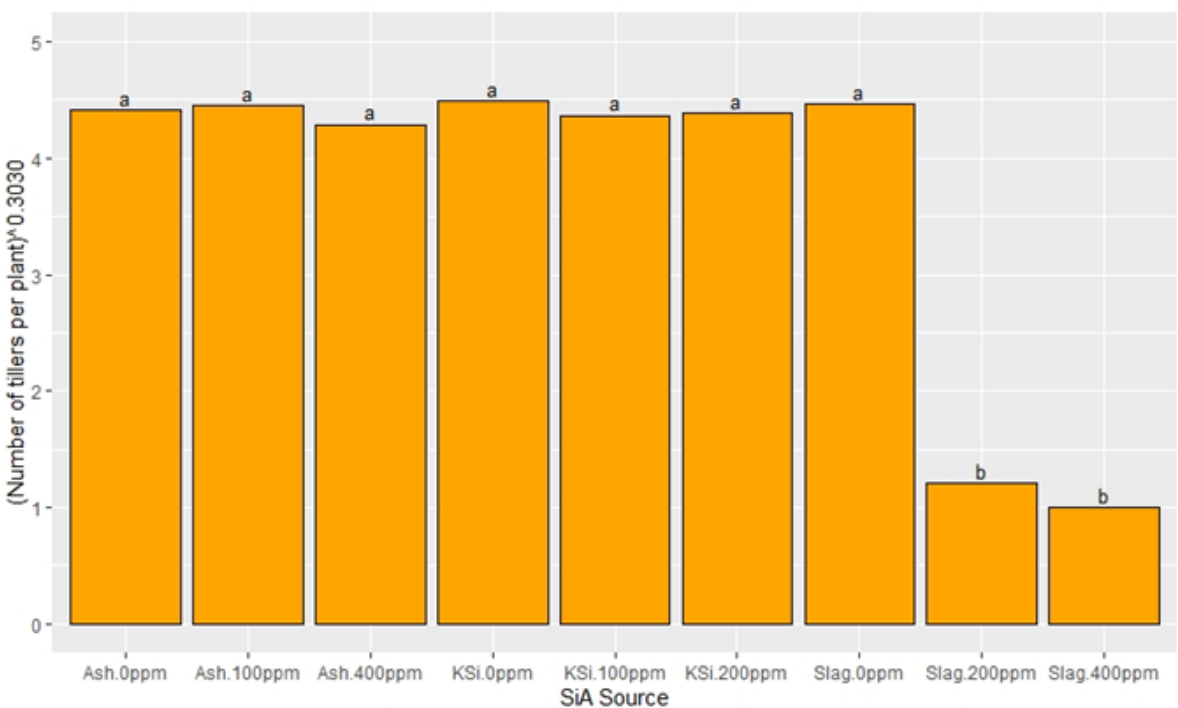
Figure 7 . Statistical summary of ( Number of tillers per plant) 0 .3030 . Significance levels were obtained with Tukey test, α = 0.05. Ash stands for rice husk ash; KSi, for potassium silicate and Slag, for ladle furnace slag.